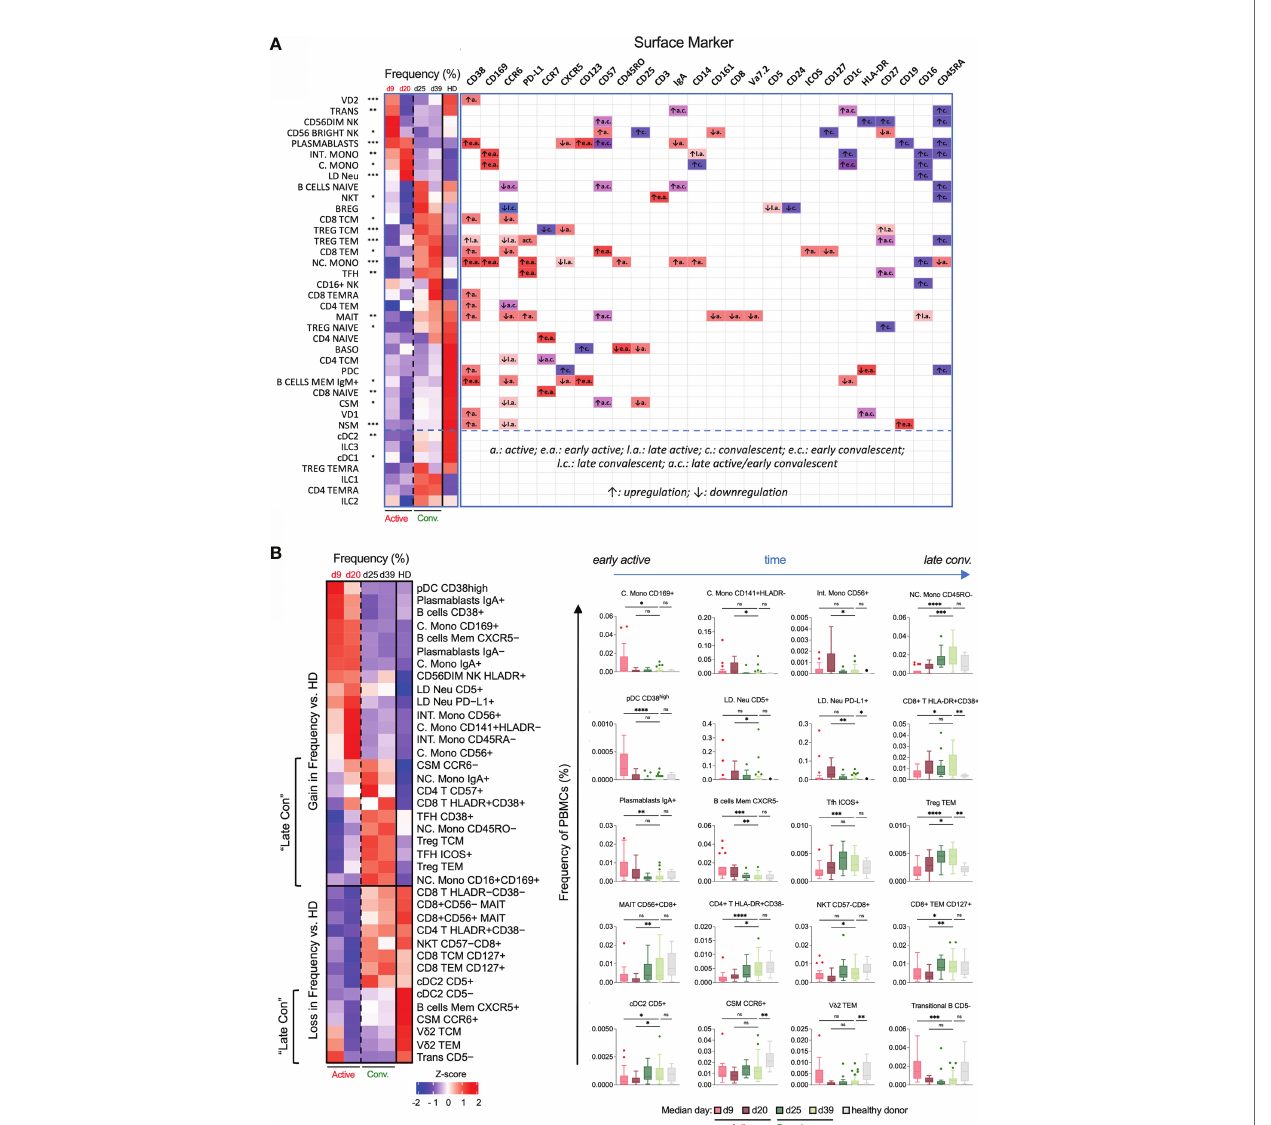
FIGURE 3 | Temporal changes in frequencies and surface marker expression pro fi les of various immunotypes during active and convalescent COVID-19. (A) Left: Heatmap of CyTOF data of the frequencies of all 38 basic immune cell populations as a function of days post illness onset (PIO) – d9 (early active), d20 (late active), d25 (early convalescence) and d39 (late convalescence). Asterisks indicate statistical signi fi cance - *p < 0.05; **p < 0.01; ***p < 0.001 (Kruskal-Wallis test with multiple comparison corrected on all disease phases and healthy controls). Right: up- or down-regulation of indicated surface markers for the 38 main immune cell populations as a function of disease phase. (B) Left: Heatmap of CyTOF data of the frequencies of the top 38 immunotypes as a function of disease phase. Right: Box-and-whiskers plots of select immunotypes showing the frequency-time relationships, with mean and IQR indicated. “ Late Con ” refers to a group of immunotypes, which fail to recover to healthy levels even in late convalescence as post-infection aberrations. Asterisks indicate statistical signi fi cance- ns, not signi fi cant, *p < 0.03; **p < 0.002; ***p < 0.0002, ****p < 0.0001 (Kruskal-Wallis test with multiple comparison corrected on each disease phases versus healthy